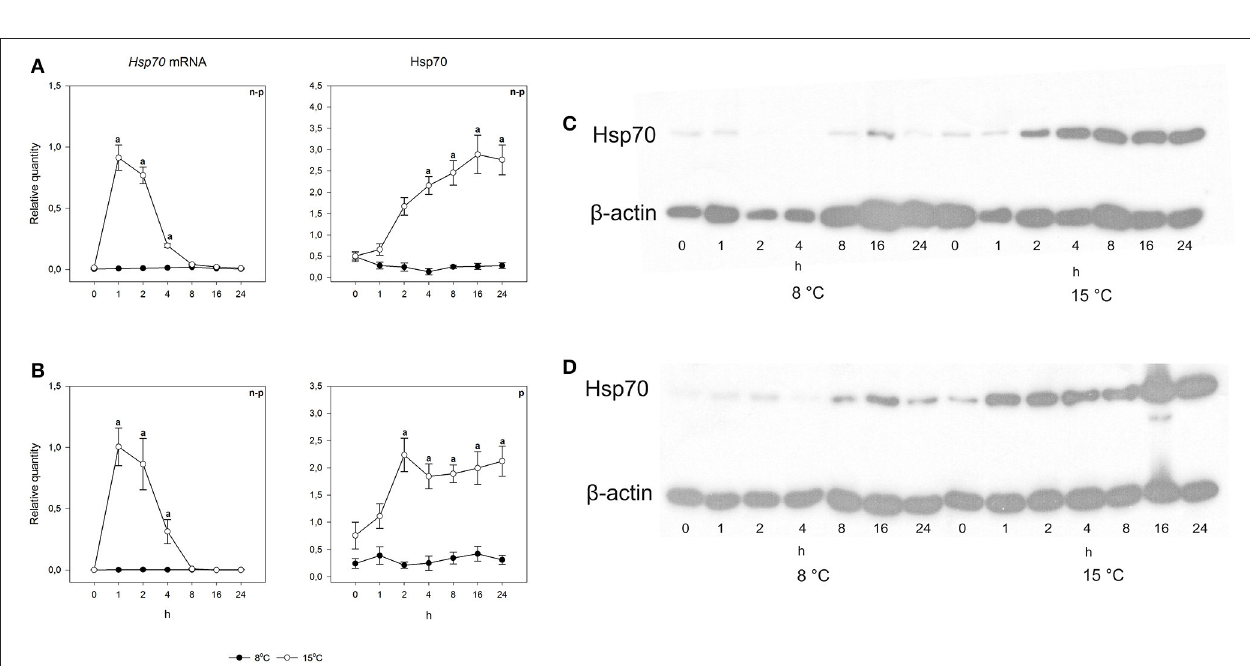
FIGURE 4 | Hsp70 mRNA and protein levels of undisturbed Arctic charr and Atlantic salmon after 1-month acclimation to 8 or 15 ◦ C in gills and liver. Relative quantities are given. The figure reproduces data of Figures 2 , 3 for giving the reader a clear picture how hsp70 mRNA and protein changes between acclimation temperatures in the two species and tissues (gills or liver).